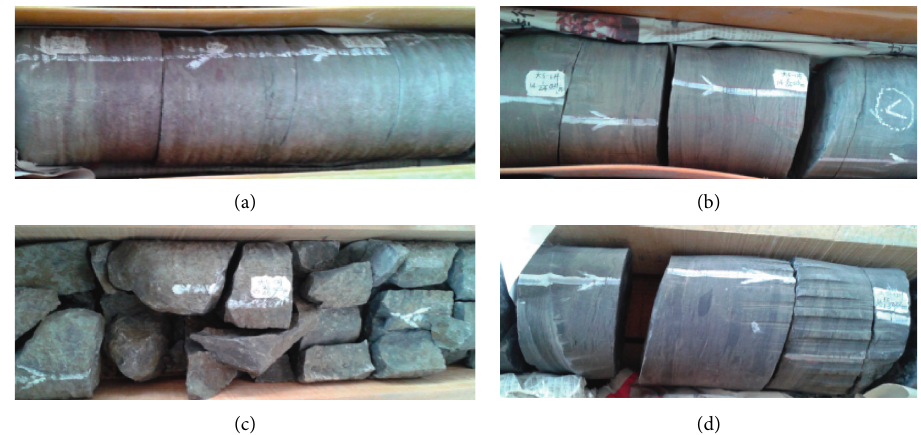
Figure 1: Origin rocks drilled from D5-1 well: (a) argillaceous siltstone, depth of 2315.7m ∼ 2320.9 m; (b) mudstone, depth